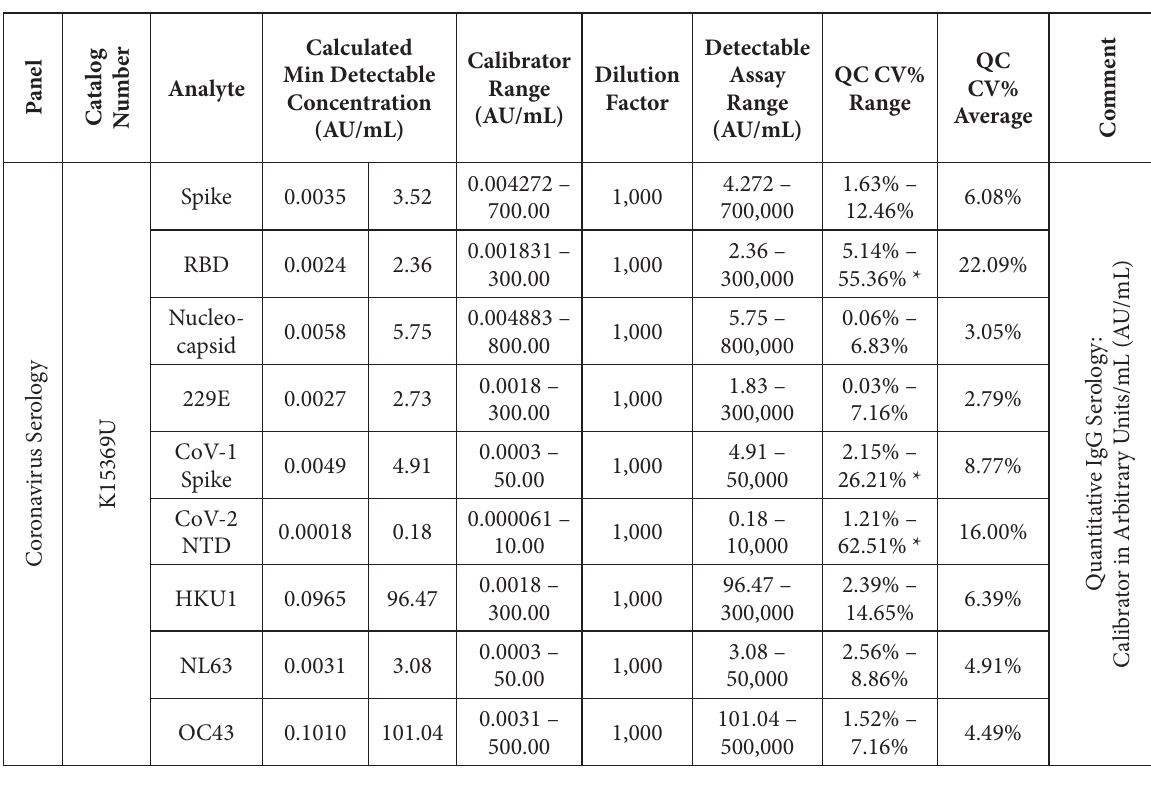
Table 1. MSD Platform Analyte Detectable Range and Quality Control